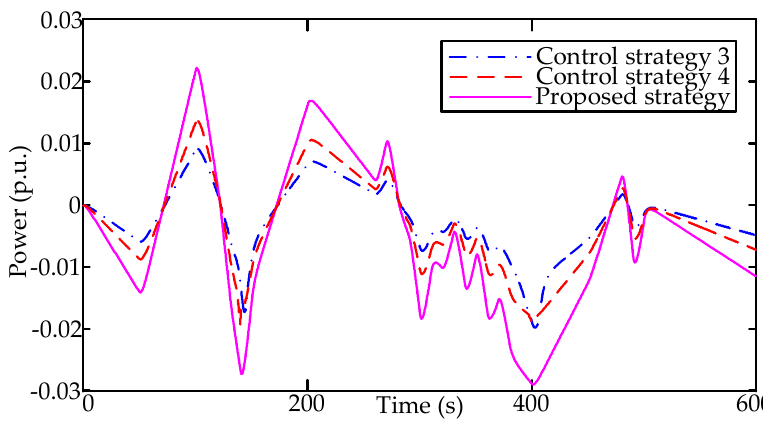
Figure 15. The power output of individual ACs under different control schemes.